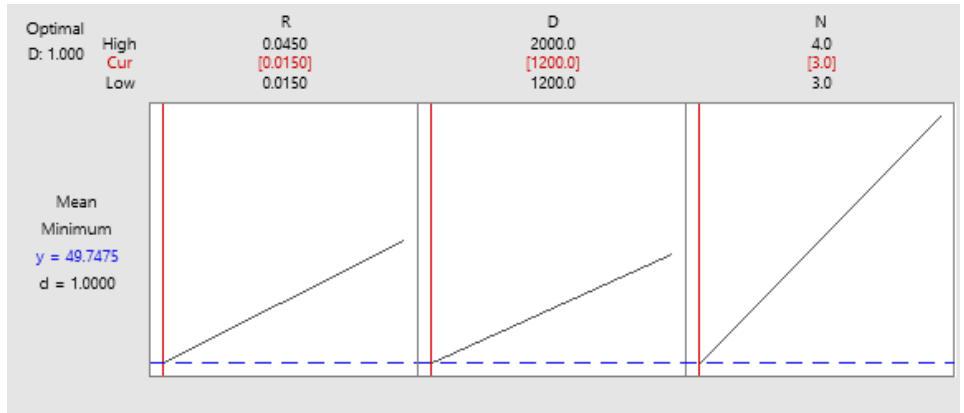
Fig. 6. Optimal solution graph [17].